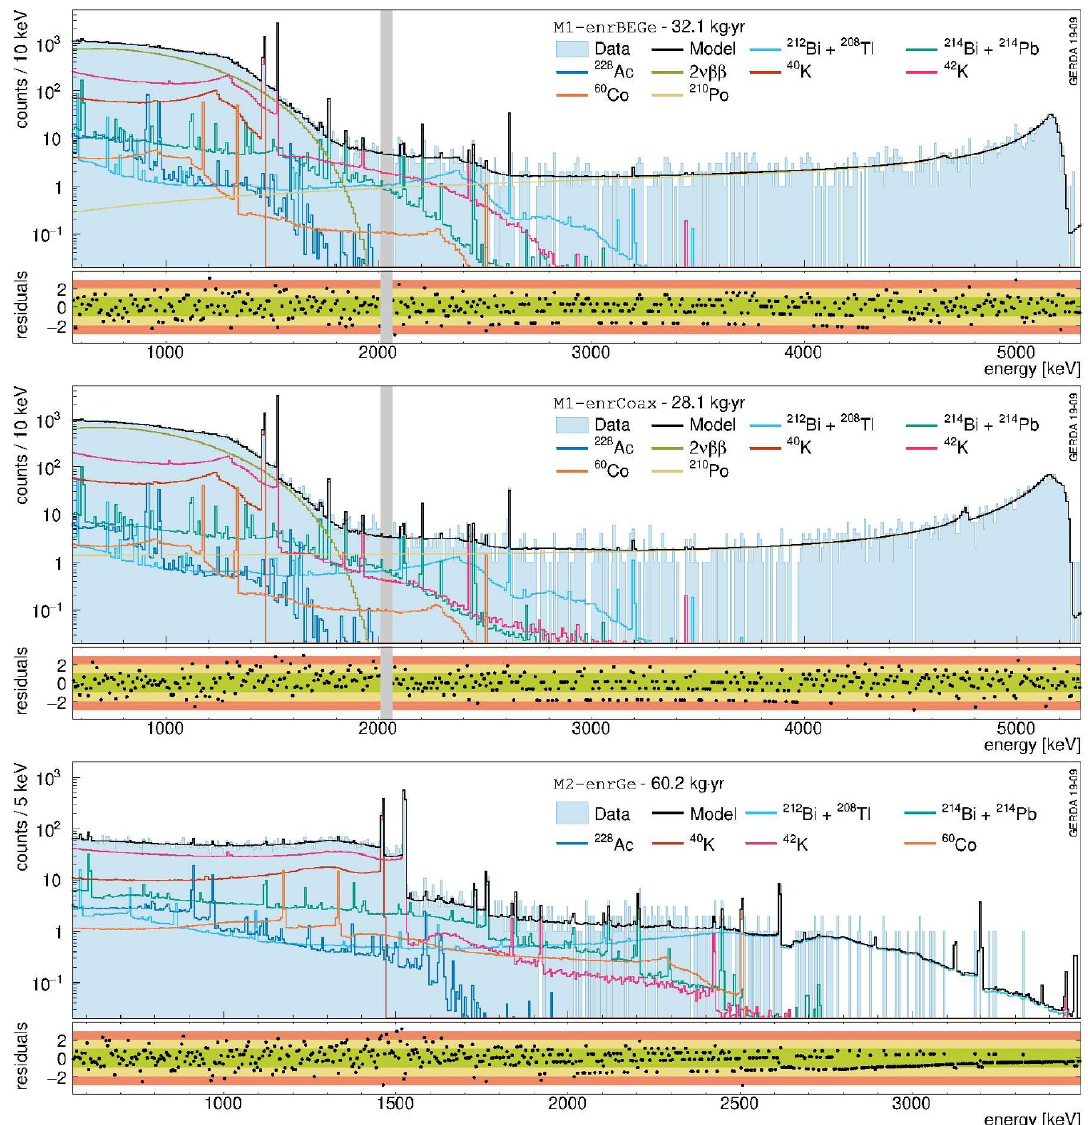
Figure 4. Background decomposition of the event energy distributions of the (from top to bottom) M1-enrBEGe , M1-enrCoax and M2-enrGe data sets. Components referring to the same background source in di(cid:11)erent locations are summed together for visualization convenience. The blinded region Q (cid:12)(cid:12) (cid:6) 25 keV is highlighted in gray. In the three lower panels displaying the normalized residual distributions the central 1 (cid:27) -, 2 (cid:27) - and 3 (cid:27) -bands are marked in green, yellow and red, respectively. Note that for bins with low expected statistics due to the discrete nature of the measured spectrum not all colored bands are meaningful